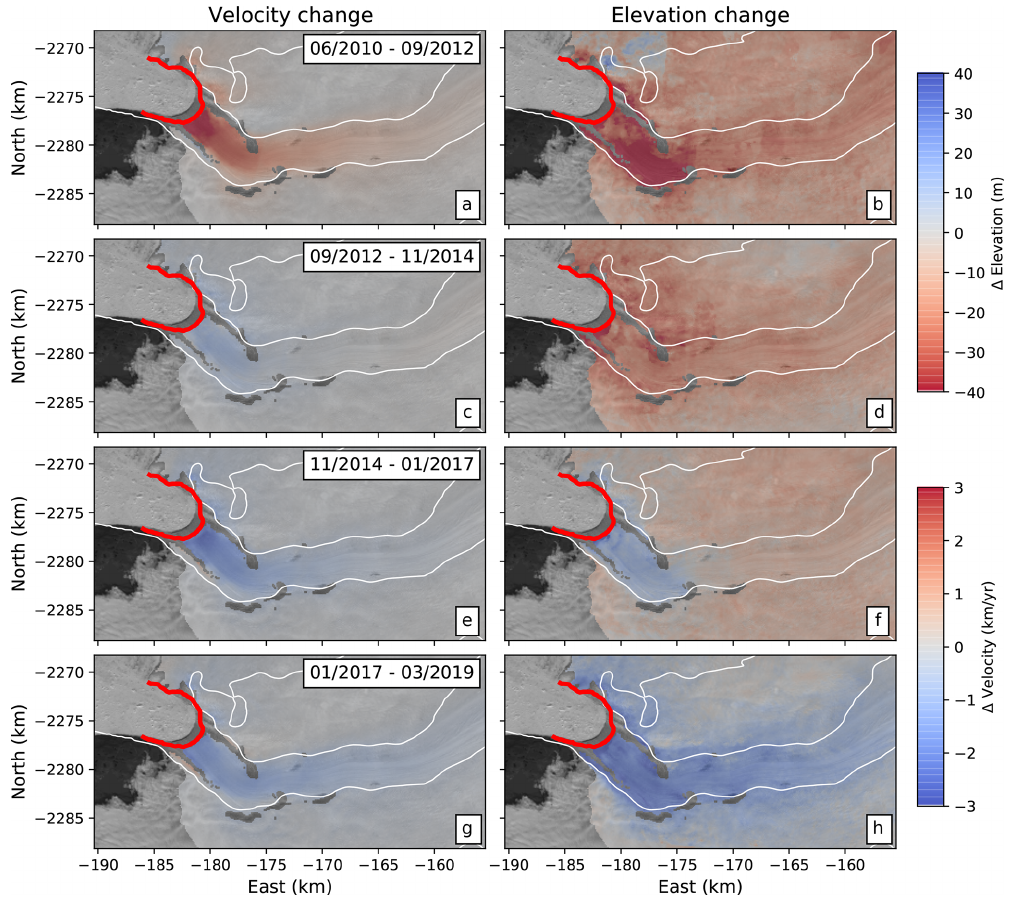
Figure 6. Long-term velocity and ice surface elevation changes for successive time periods of 2.2 years. (a, b) June 2010 to September 2012: the glacier is accelerating (positive velocity anomaly) and thinning (negative elevation anomaly), with higher rates of thinning within the glacier. (c, d) September 2012 to November 2014: velocities show slight deceleration while the ice surface lowers over a wider area, indicating persistent surface melt. (e, f) November 2014 to January 2017: this time period contains the initiation of the 2017 slowdown, which is associated with ice thickening in the main trunk of the glacier. Note the continuing surface melt signal indicated by lowering distal to the glacier. (g, h) January 2017 to March 2019: slight decrease in glacier flow speed and more widespread increase in ice surface elevations due to positive SMB can be